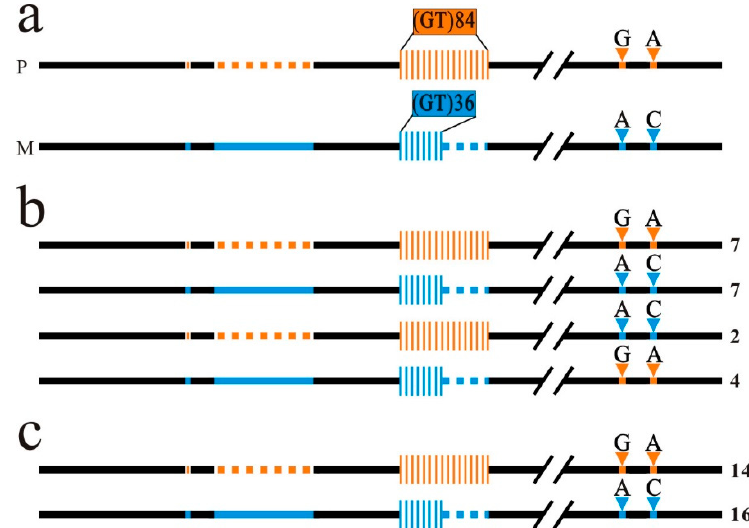
Figure 2. Homologous recombination occurs at GTM 1 region in the eggs of a heterozygous individual. ( a ) The paternal and maternal genetic makers flanking the GTM 1. P and M indicate the paternal and maternal alleles. ( b ) The linkage patterns of the paternal and maternal genetic makers flanking the GTM 1 in the eggs of a hybrid. ( c ) No homologous recombination clone was detected in the PCR products amplified from the equivalent mixture of homozygous paternal and maternal genomic DNA. Black lines represent the conserved regions. Orange and blue symbols represent the paternal and maternal genetic markers as indicated in Figure 2. Number of sequenced clones is indicated at the right. Intra-allelic recombination clones with contraction or expansion of GTM 1 detected in all the experimental and control samples were eliminated in the statistical data.